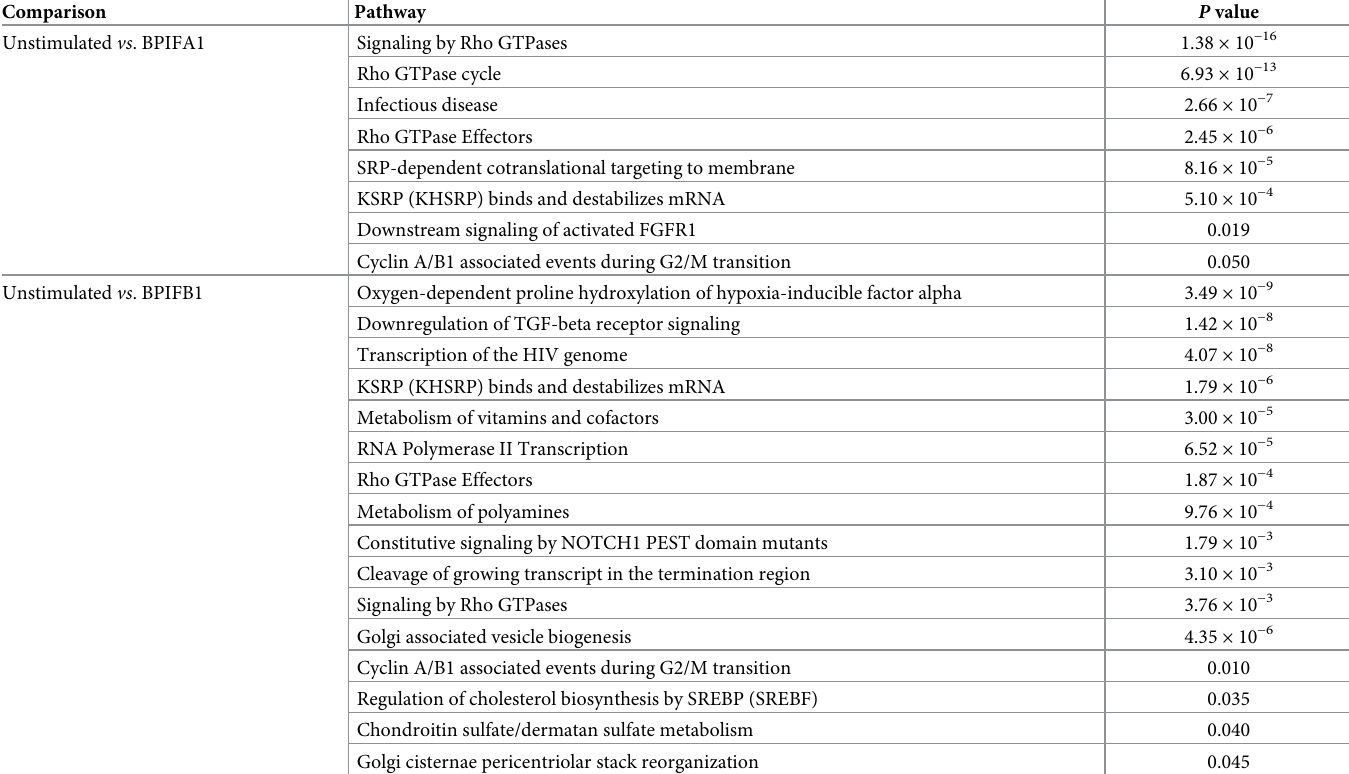
Table 3. Overrepresented pathways by Sigora analysis in genes that were differentially expressed in response to BPIFA1 or BPIFB1 treatment compared to unsti- mulated cells.